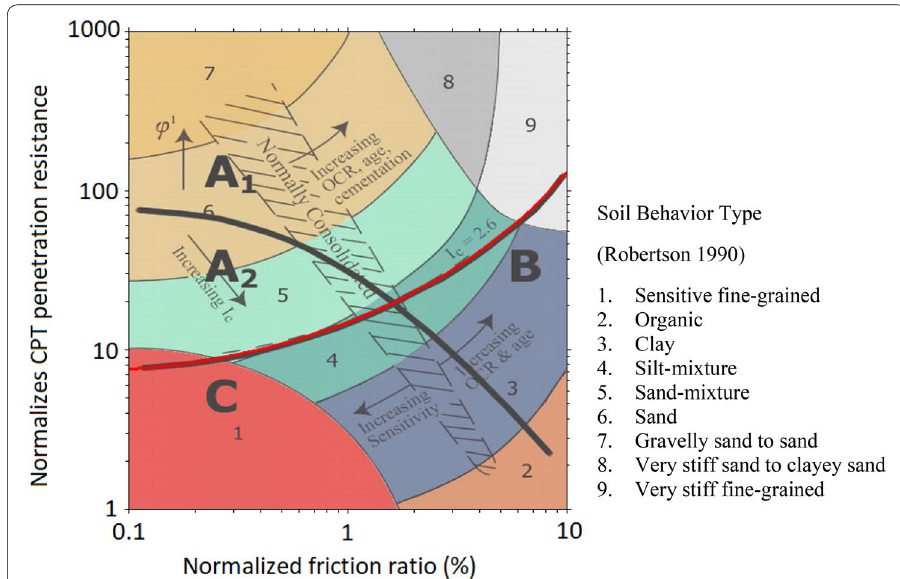
Fig. 1 Contours of the soil behavior type index ( I c ) on normalized SBT Q t − F r chart (SBT zones based on